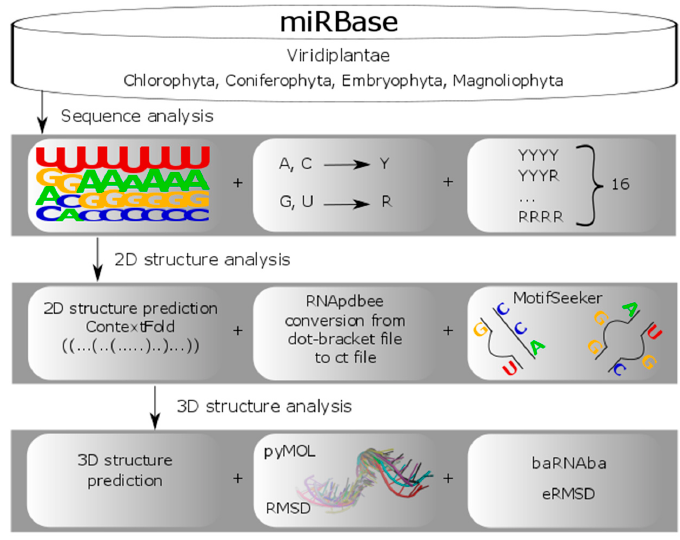
Figure 1. Precursor microRNA (pre-miRNA) analysis